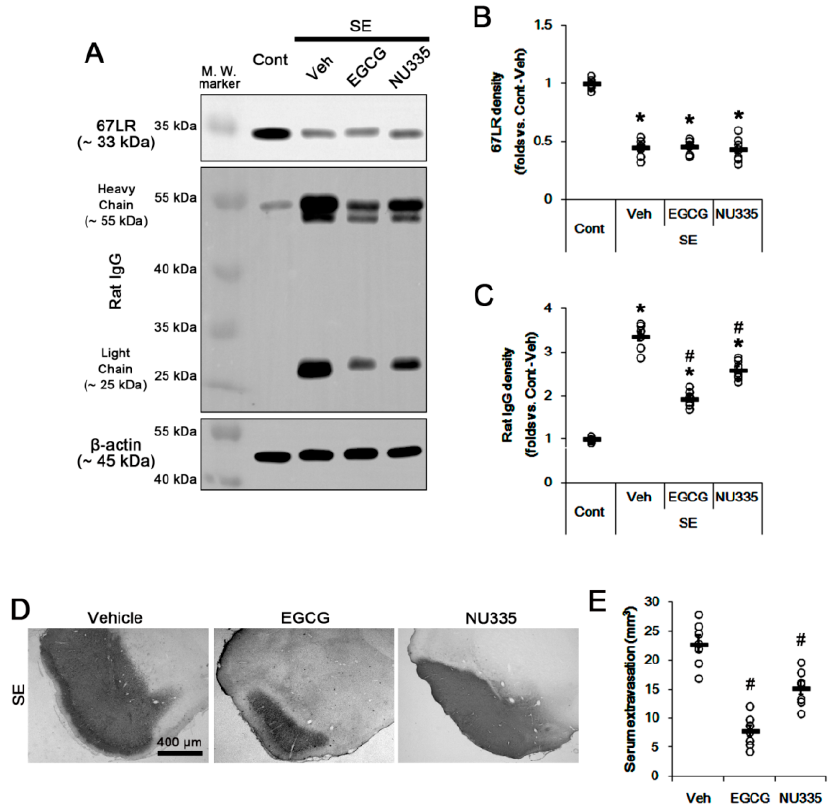
Figure 2. Effects of EGCG and NU335 on vasogenic edema formation in the piriform cortex (PC) following status epilepticus (SE). EGCG and NU335 do not affect SE-induced reductions in 67-kDa laminin receptor (67LR) expression. However, both EGCG and NU335 attenuate serum extravasation and vasogenic edema formation induced by SE. ( A ) Representative Western blot images for 67LR and rat immunoglobulin G( IgG) in the PC. ( B , C ) Quantitative values of the effect of EGCG and NU335 on 67LR ( B ) and serum extravasation ( C ) in the PC following SE ( n = 7, respectively). Open circles indicate each individual value. Horizontal bars indicate mean value. Error bars indicate S.E.M. Significant differences are * ,# p < 0.05 vs. control (non-SE) animals and vehicle-treated SE-induced animals, respectively. ( D ) Representative photographs for vasogenic edema in the PC. ( E ) Quantitative values of the effects of EGCG and NU335 on serum extravasation. Open circles indicate each individual value. Horizontal bars indicate mean value. Error bars indicate S.E.M. Significant differences are * p < 0.05 vs. vehicle-treated animals (Student t -test).